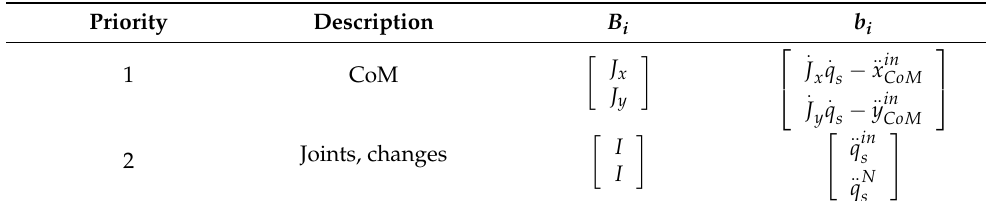
Table 3. Vectors in the optimization of trajectory